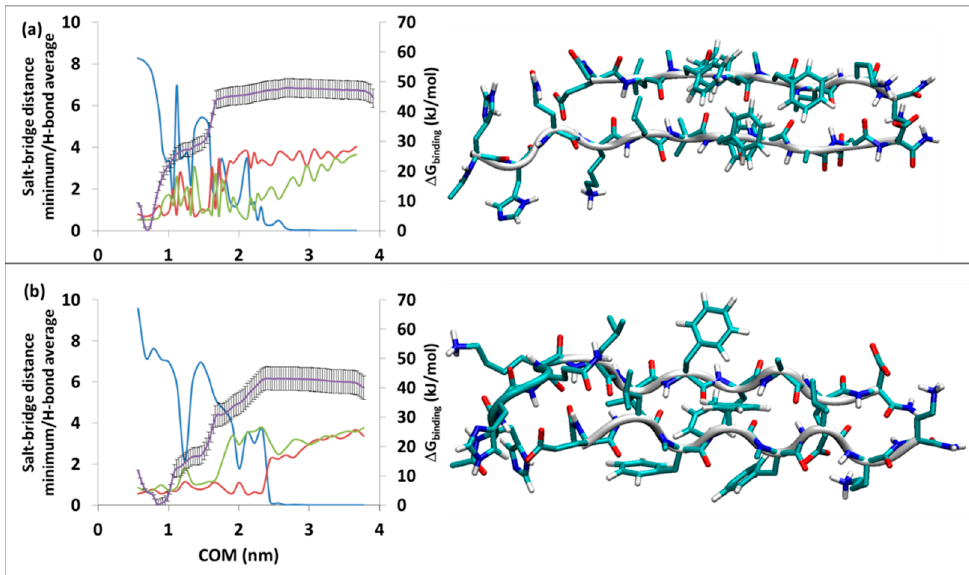
Figure 3. Binding of SGD1 to R at ( a ) R T -SGD1, on the top, ( b ) R B -SGD1, in the bottom. The right-hand axis is for PMF curve (purple line) in kJ/mol, the error bars are included (±1 σ ). The left-hand axis is the average intermolecular H-bonds (blue line) and salt-bridge distances at the polar charged residues in nm; Lys16-glu8 ′ (green line) and minimum distances for Glu22-daba1 ′ , Glu22-orn2 ′ , Asp23-daba1 ′ , Asp23-orn2 ′ (red line). The horizontal axis is the separation of the centers of mass in nm.